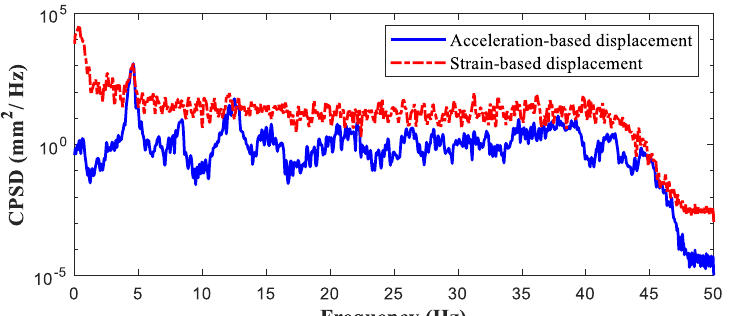
The scaling factor was obtained from the strain and acceleration measurements using Equation (5). Figure 14 plots the cross power spectral densities (CPSDs) of the acceleration- and strain-based displacements. The scaling factor was 0.044 at the first natural frequency of 4.49 Hz. At this frequency, the CPSD of the calibrated strain-based displacement exhibited the same power as the acceleration-based displacement.